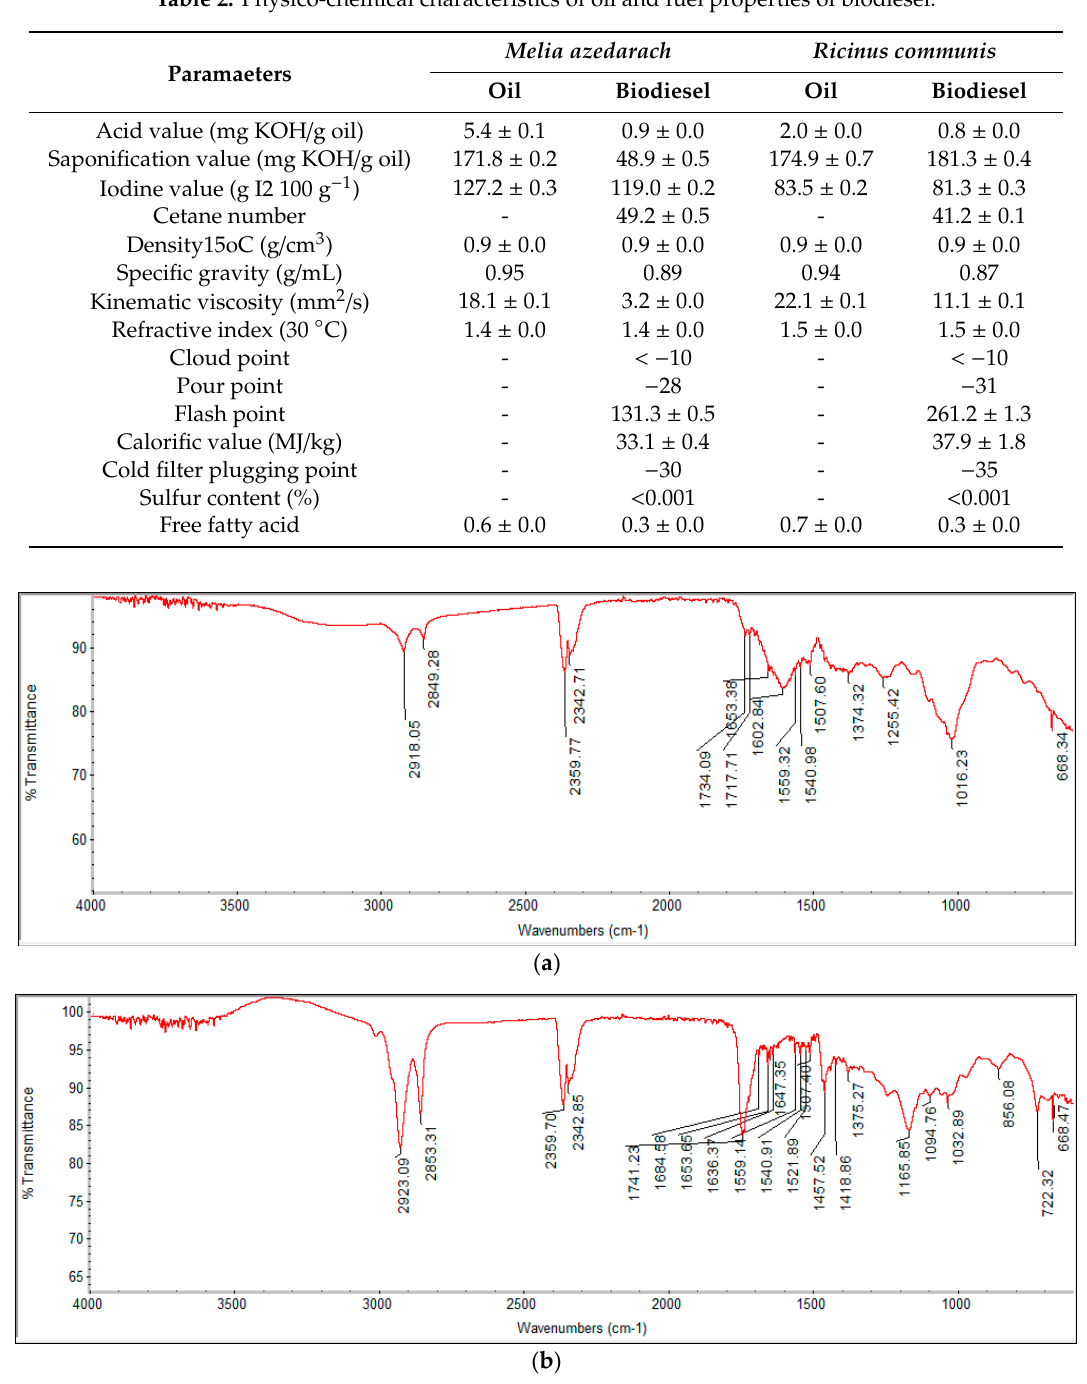
Figure 3. ( a ). FTIR spectrum of extracted Biodiesel of R. communis ( b ) FTIR spectrum of Figure 3. ( a ) FTIR spectrum of extracted Biodiesel of R. communis ( b ) FTIR spectrum of extracted extracted Biodiesel of M. azedarach. Biodiesel of M. azedarach